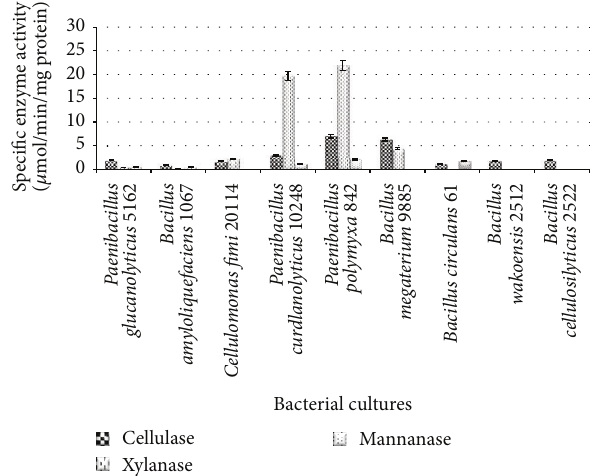
Figure 2: Specific CMCase, xylanase, and mannanase activities of cellulolytic bacteria grown in xylan medium.